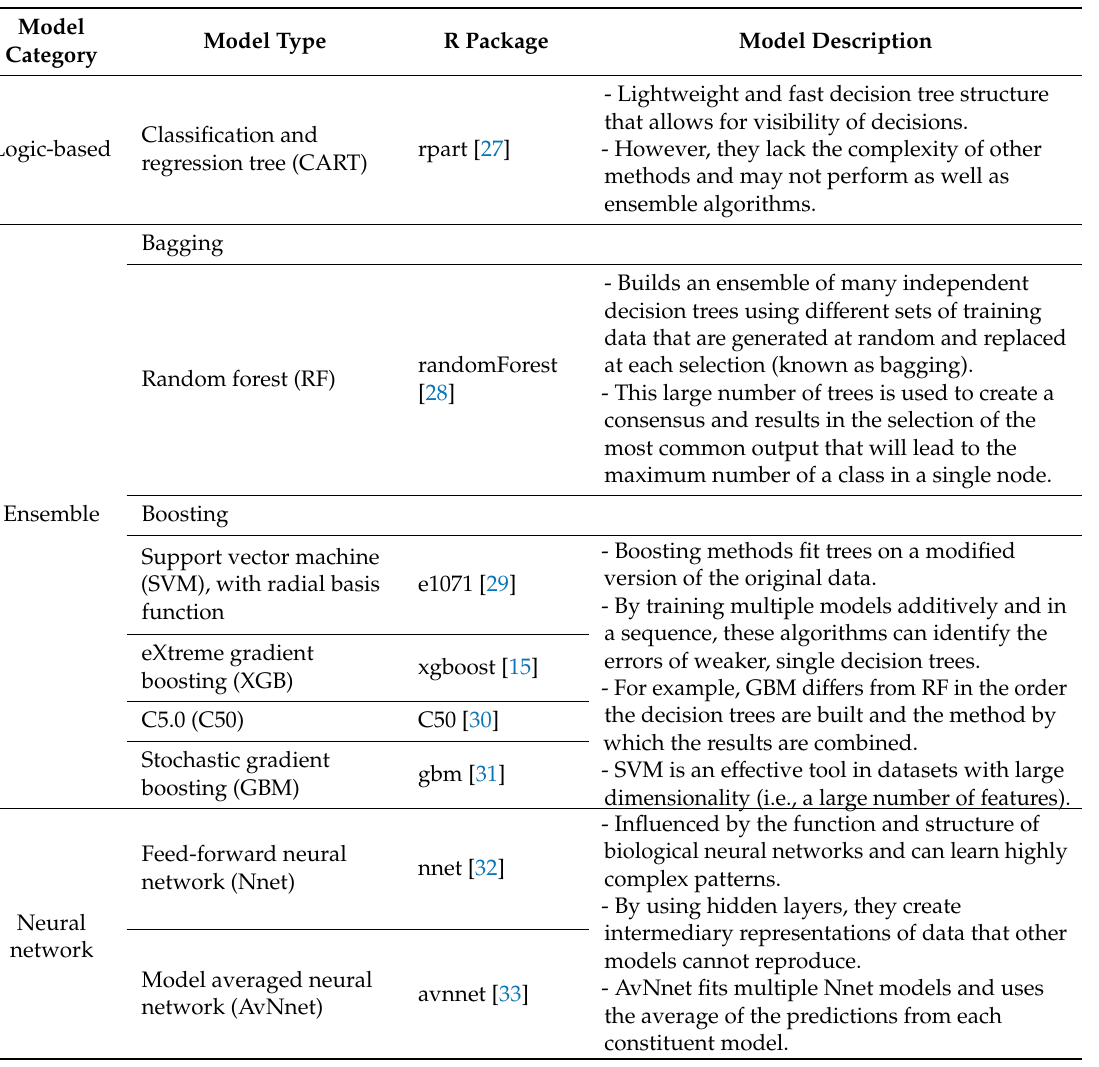
Table 3. Model category, type, R packages used and short descriptions of classification